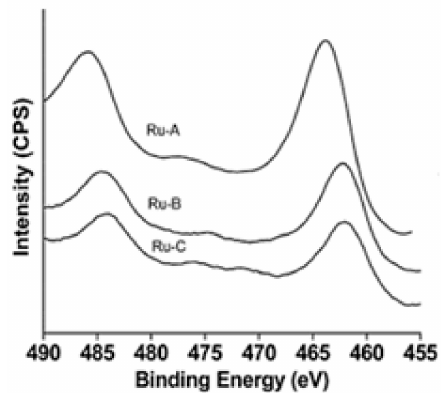
Figure 5. Ru 3p XPS spectra of ruthenium-encapsulated POPs. Reproduced with permission from